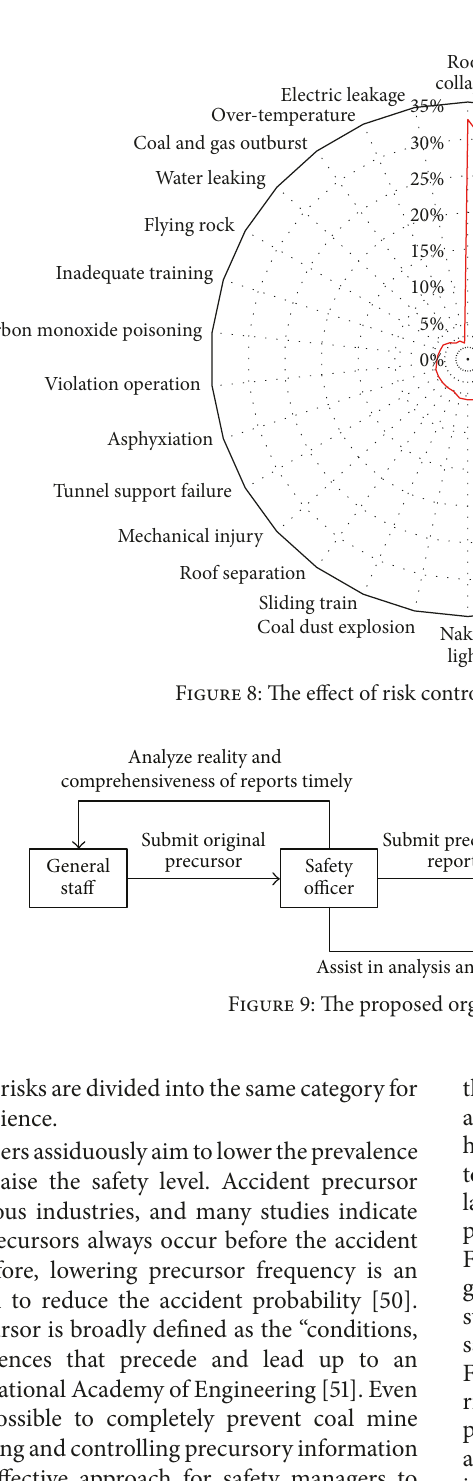
Figure 9. The real executors of precursor management